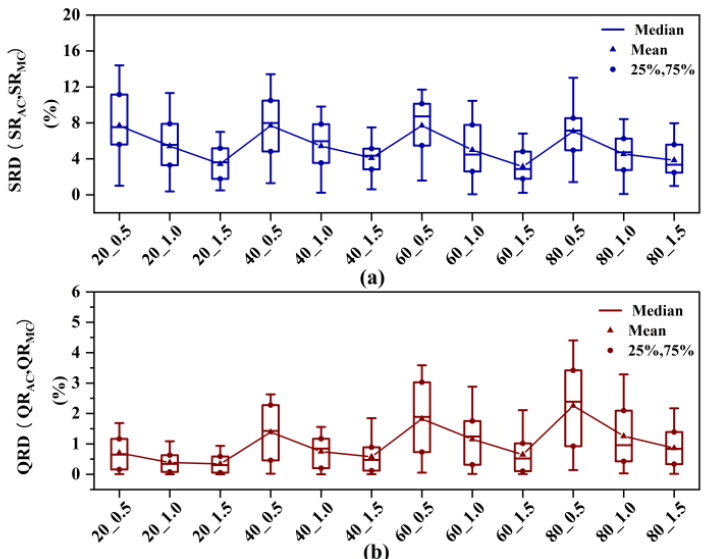
Figure 7. Quartile graph of SRD, QRD for every benchmark problem. ( a ) Quartile graph of SRD at different fault levels. ( b ) Quartile graph of QRD at different fault levels.